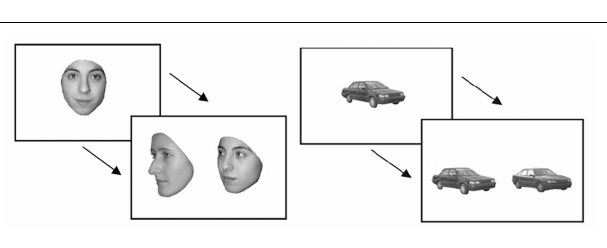
FIGURE 1 | In Experiment 1A, participants had to decide which of the left or right stimulus (face or car) presented at the bottom of the panel corresponded to the target (face or car) presented at the top of the panel. The stimuli were presented in upright or inverted orientation.